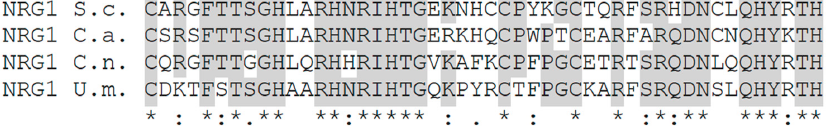
Figure 1. Amino acid sequence alignment of the conserved domain of NRG1. Identically conserved residues are shaded, asterisks mark entirely conserved residues and asterisk and dots indicate similar residues. (S. c: Saccharomyces cerevisiae , C. a: Candida albicans , C. n: Cryptococcus neoformans , U. m: U. maydis ).